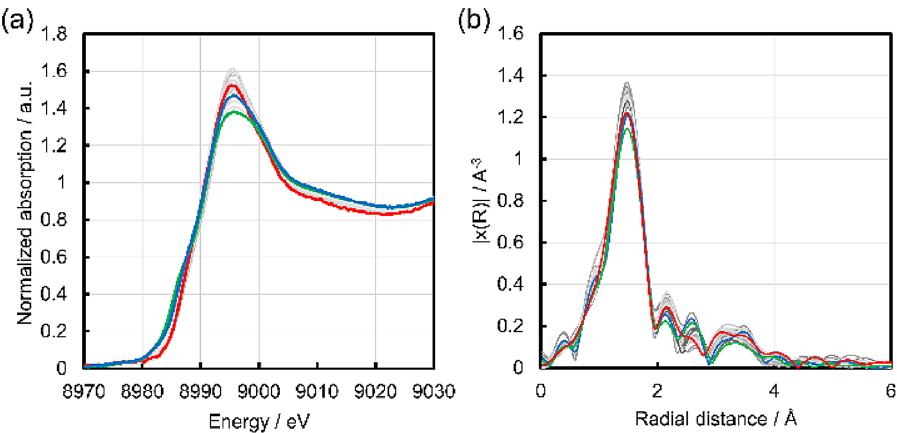
Figure 6. Plots of the specific activity against ( a ) the intensities of FT EXAFS at 1.5 FT EXAFS at 2.1 . Å